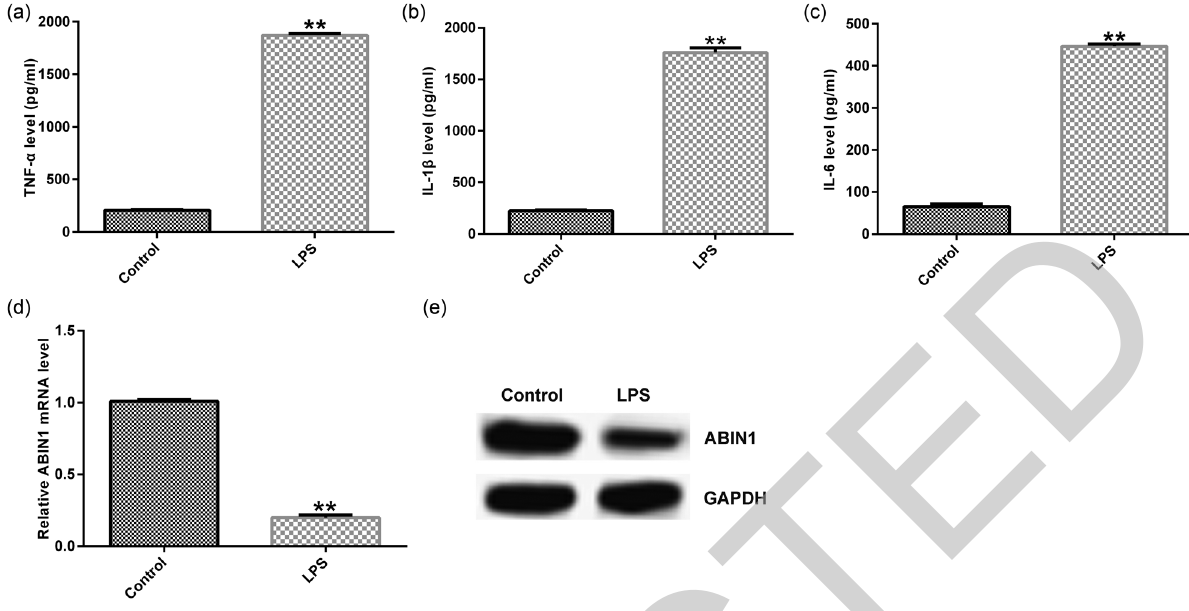
Figure 1: Expression of ABIN1 was suppressed and in fl ammatory cytokines were enhanced in LPS - induced macrophages. Macrophages were stimulated by 1 μ g/mL LPS for 4 h. ( a ) TNF - α , ( b ) IL - 1 β , and ( c ) IL - 6 levels in RAW264.7 macrophages. ( d ) ABIN1 mRNA and ( e ) protein expression in macrophages were assessed by qRT - PCR and western blot assay, respectively. ** p < 0.01 vs control.